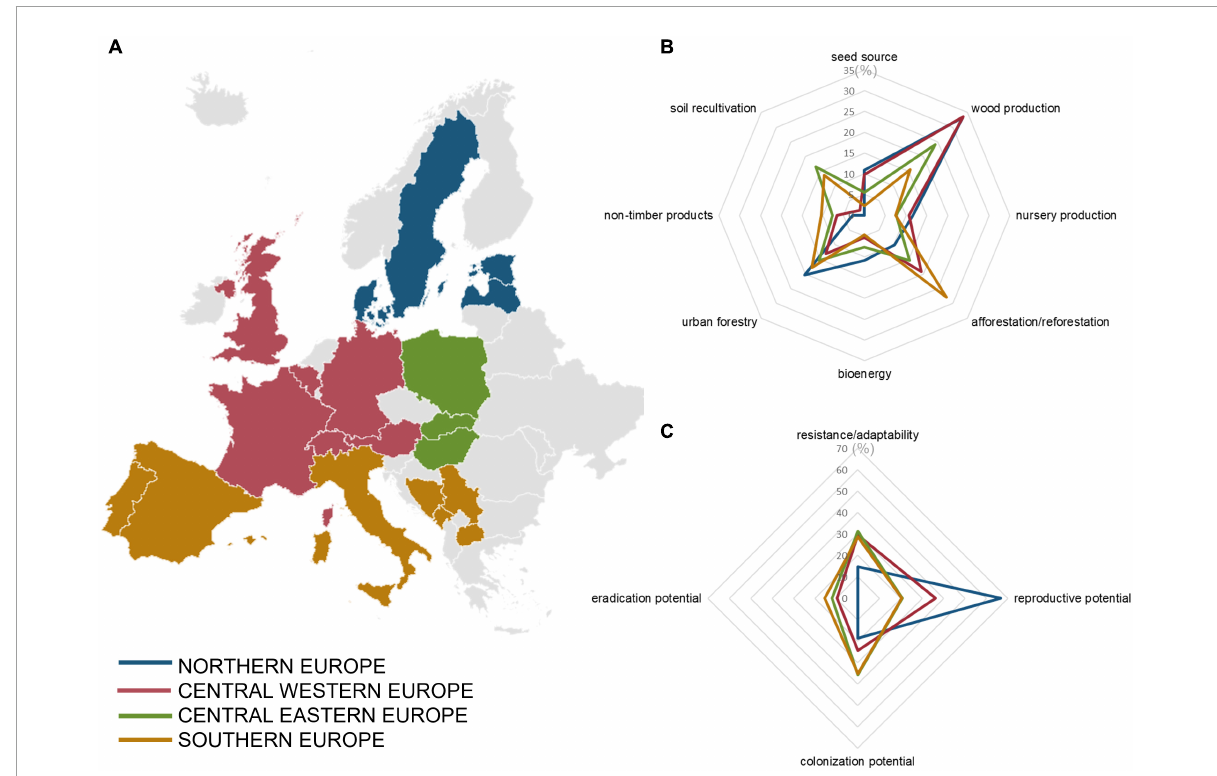
FIGURE3 Scope of study and summary of results from the questionnaire. (A) The participating countries in the WG2-D6, divided into climatic zones according to Härkönen et al. (2019). (B) Summarized relative frequency (%) of reported keywords regarding use in forestry of NNTs. (C) Summarized relative frequency (%) of reported keywords regarding invasive potential of NNTs. The reference definitions for all keywords are provided in the section “Glossary.”